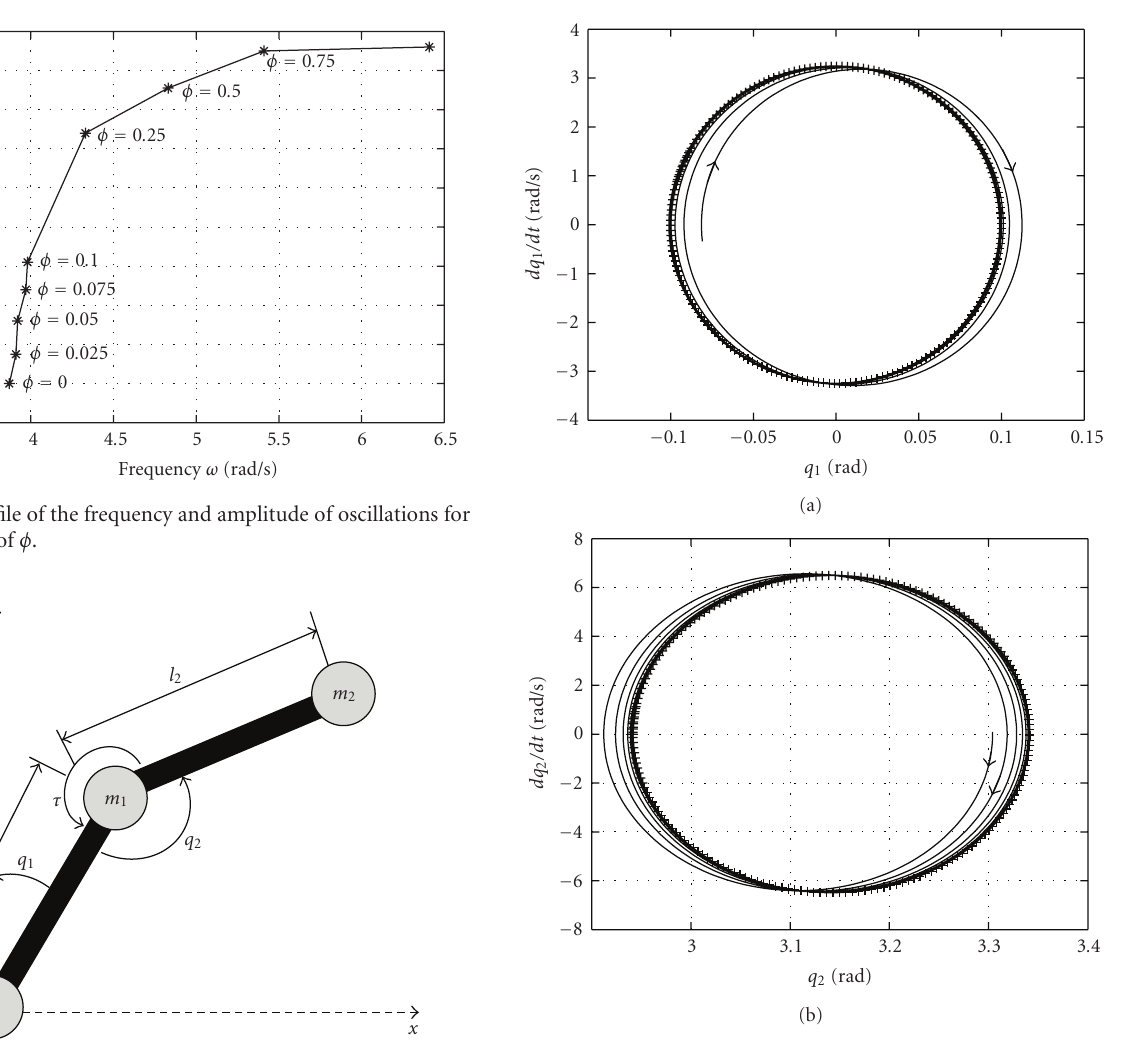
Figure 3: Schematic diagram of the acrobot where l 1 and l 2 denote the length of the nonactuated and actuated links, respectively; and m 1 and m 2 are the masses of each link.